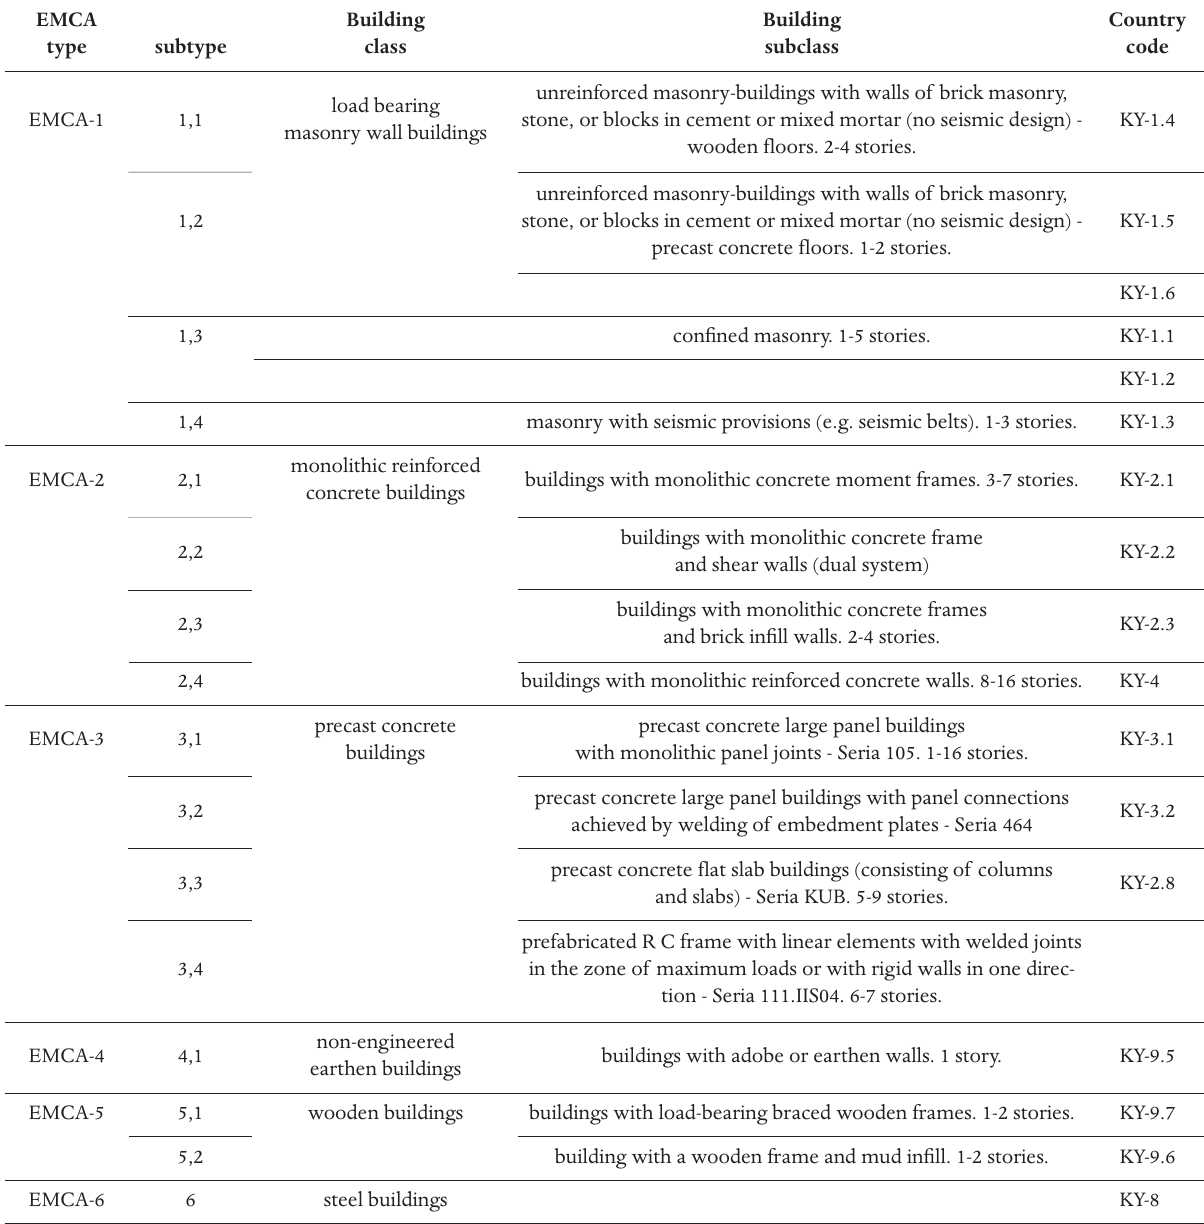
Table 1. The EMCA building typology for Central Asia. An example for Kyrgyzstan (KY) is provided that shows the link of the EMCA build- ing types to the national building typologies (Country